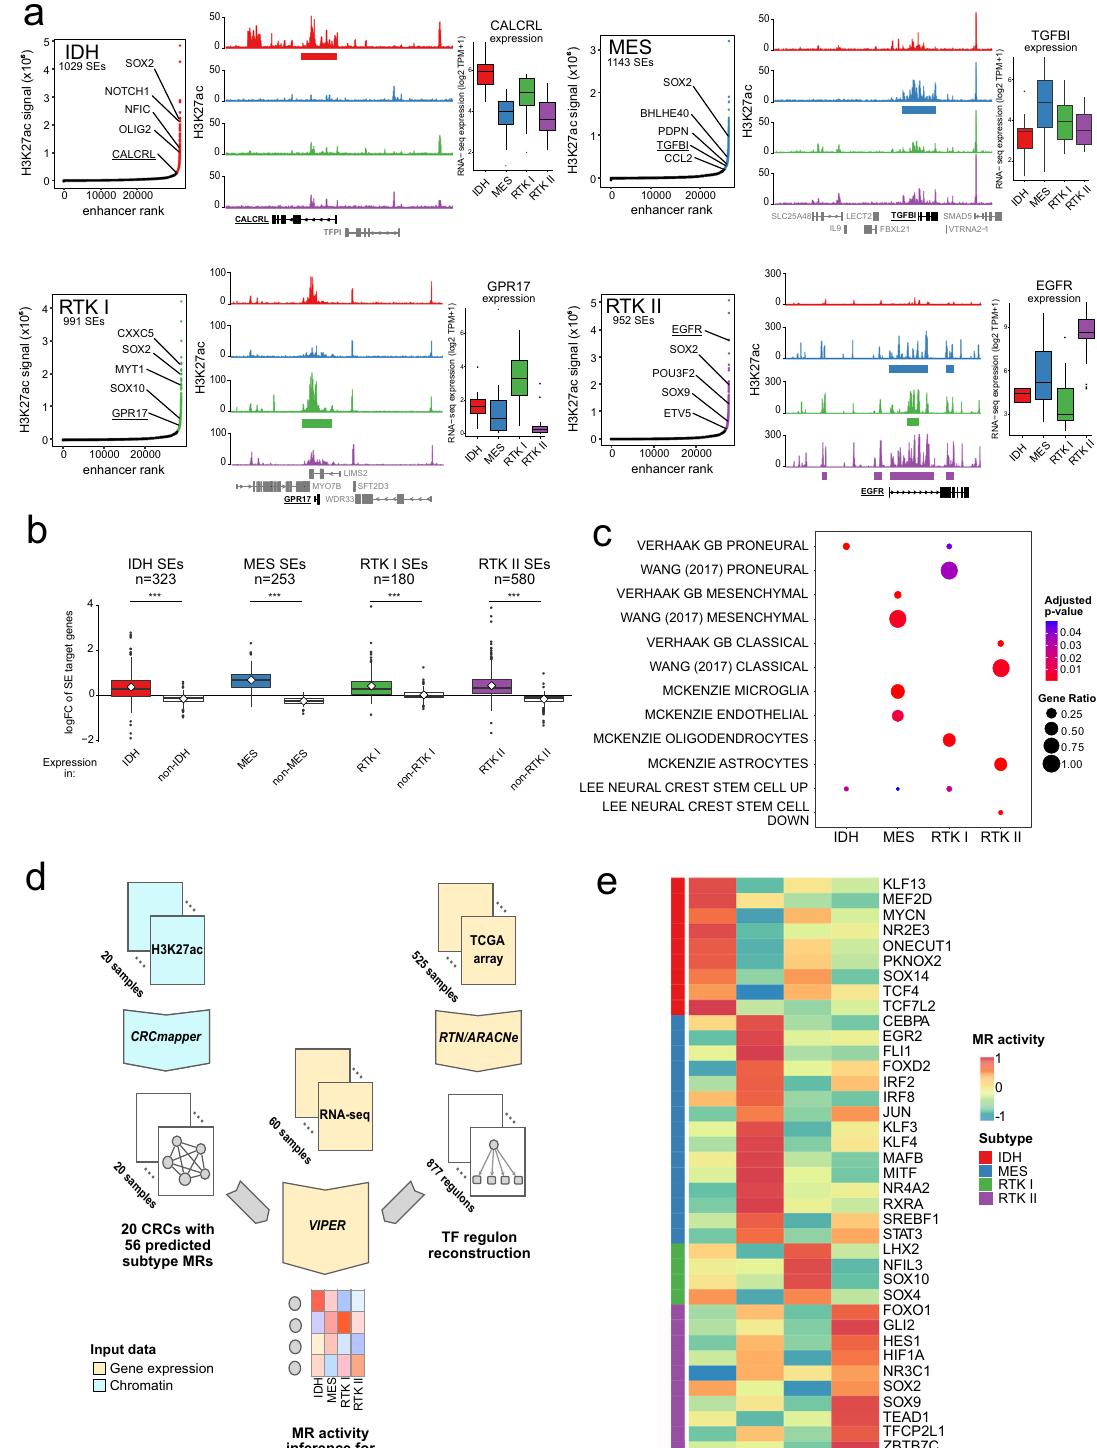
SOX10 is over-expressed in RTK I tumours (Fig. 5b), correlating with genic hypomethylation and increased H3K27ac signal (Fig. 5c). We screened glioblastoma cell lines and selected two lines exhibiting high SOX10 expression and promoter hypo- methylation, characteristic of RTK I patient samples for use as in vitro models: ZH487, a primary glioblastoma cell line that